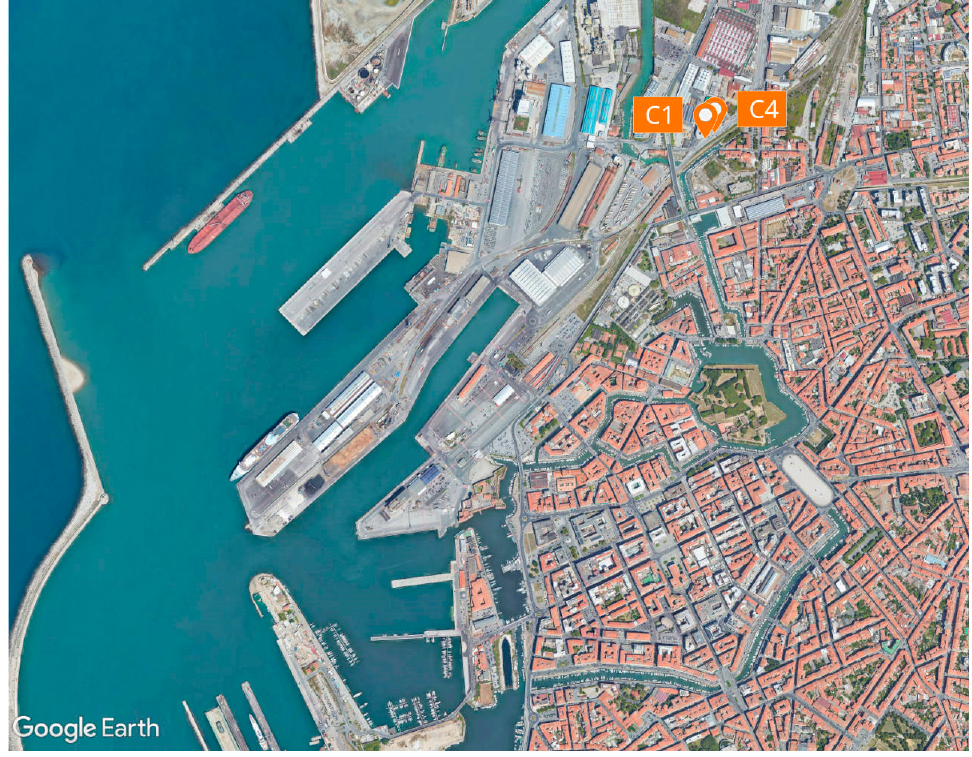
Figure 5. Positioning of the measurement point in Livorno.